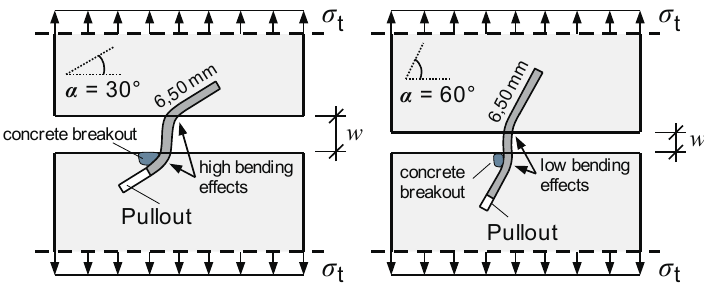
Figure 9. Pullout mechanisms of embedded steel fibres under 30° and 60°.